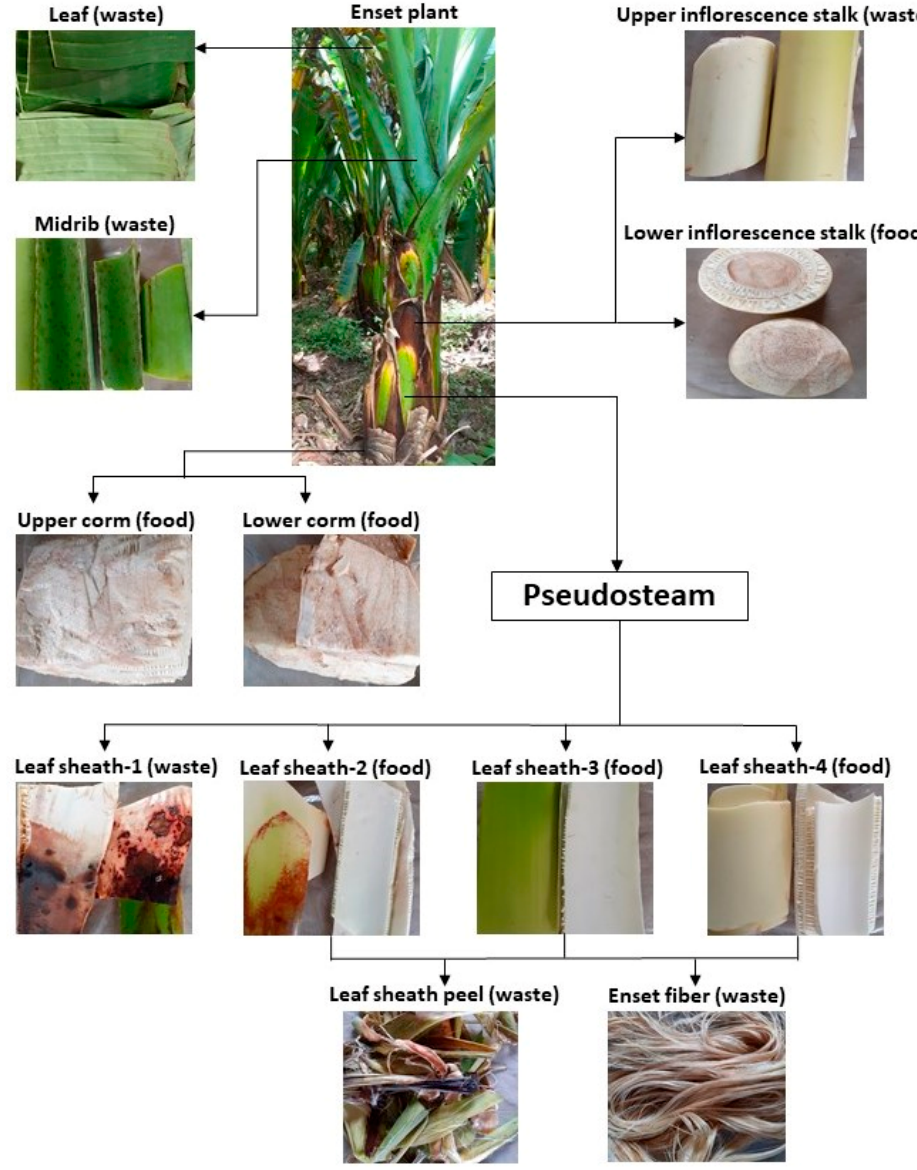
Figure 1. Morphology of Enset biomass based on traditional Enset food processing. (This photo was taken by one of the authors at a private Enset plantation in Wolkite, Ethiopia).